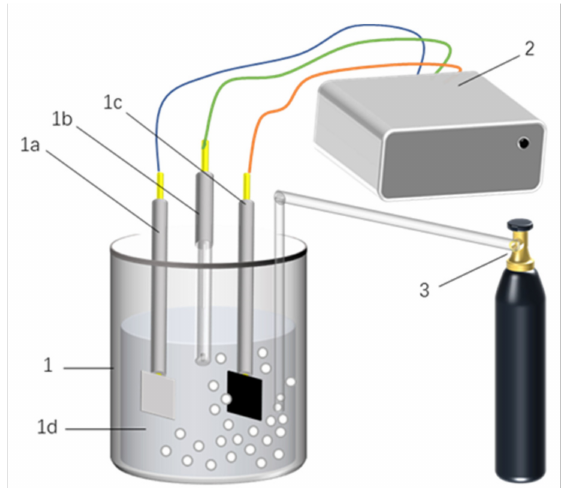
Figure 3. Schematic diagram of three electrodes test system (1—the electrolytic cell; 1a—platinum electrodes; 1b—Ag/AgCl reference electrodes; 1c—PAQ/MWCNTs modified electrode; 1d—lithium bis(trifluoromethanesulfonyl)imide electrolyte; 2—electrochemical workstation; 3—gas cylinders and